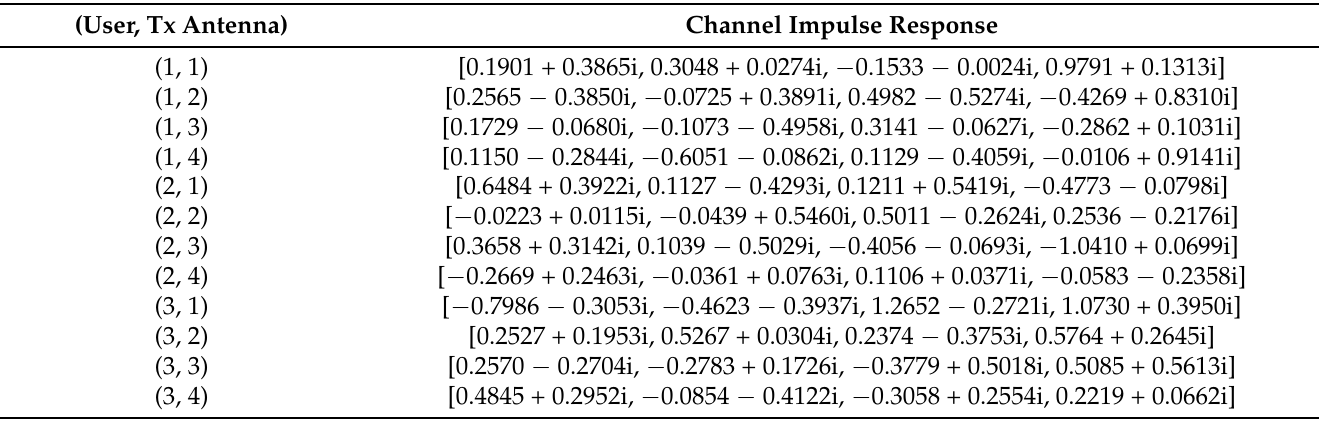
Table 2. A realization of channel impulse responses of every user and transmit antenna.